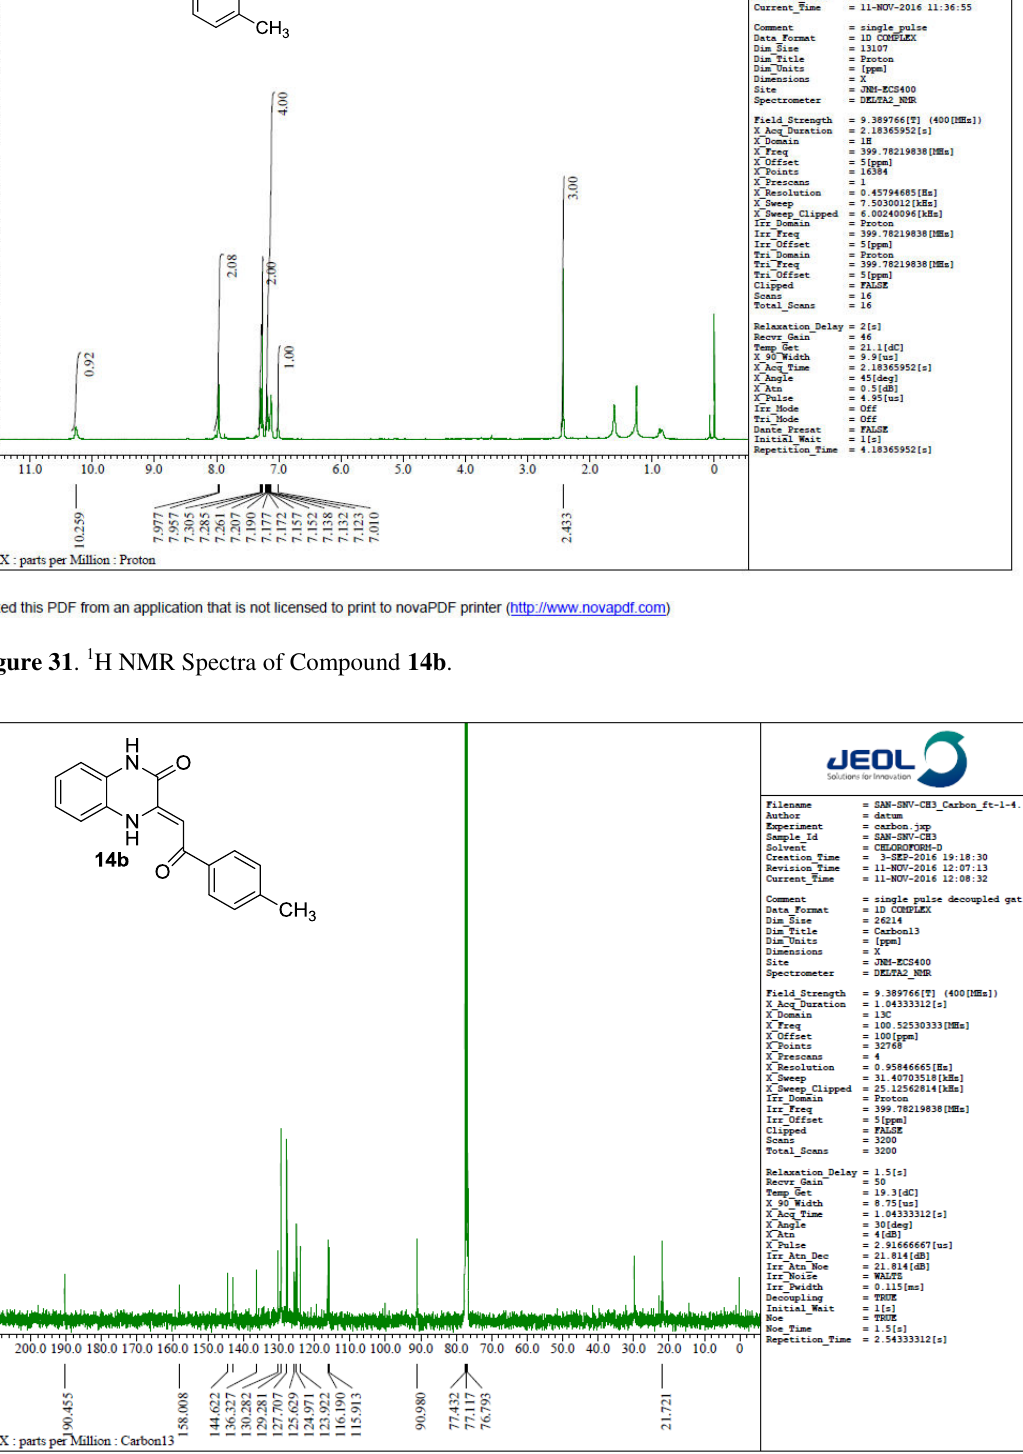
Figure 32 . 13 C NMR Spectra of Compound 14b